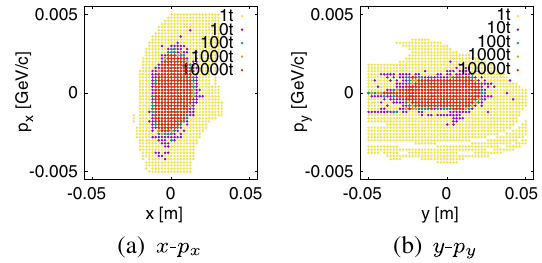
FIG. 9. Dynamic aperture in physical (a) x - p planes. Results from tracking through a different number of turns: 1, 10, 100, 1000, 10000 turns are superimposed. The dynamic aperture defined by tracking for 100 turns and 1000 turns has only a small difference and converges when the number of turns is more than